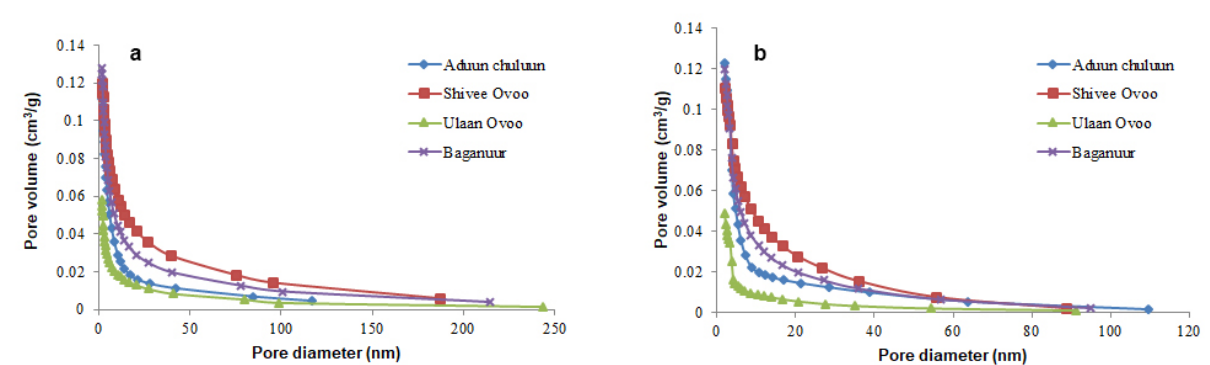
Fig. 2. The distribution curve of porous for activated carbons, a - adsoption; b -